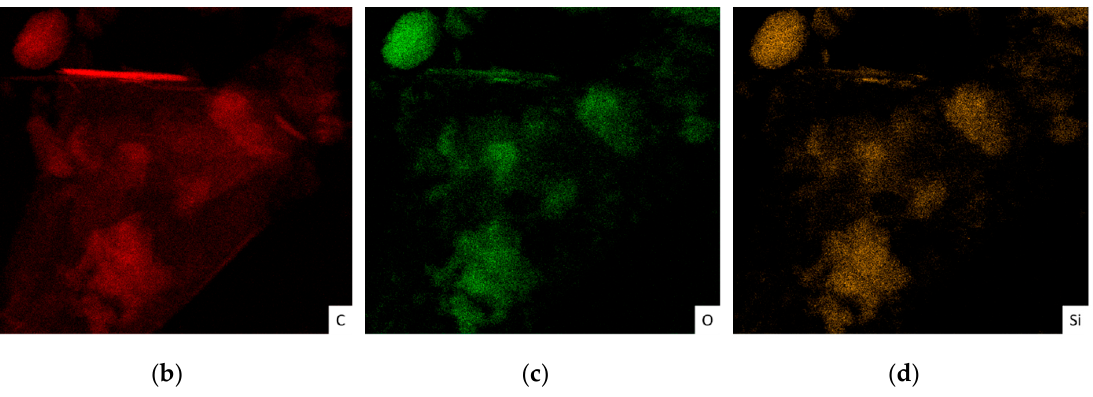
Figure 2. Bright field image and corresponding EDS (Energy Dispersive X-ray Spectrometry) maps of functionalized graphene oxide (fGO) flakes observed by scanning transmission electron microscope (S/TEM). ( a ) TEM micrograph; ( b ) carbon element map; ( c ) oxygen element map; ( d ) silicon element map.